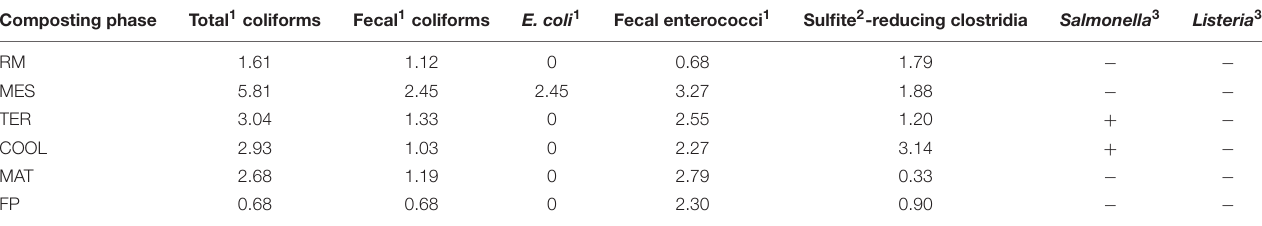
TABLE 1 | Fecal contamination of